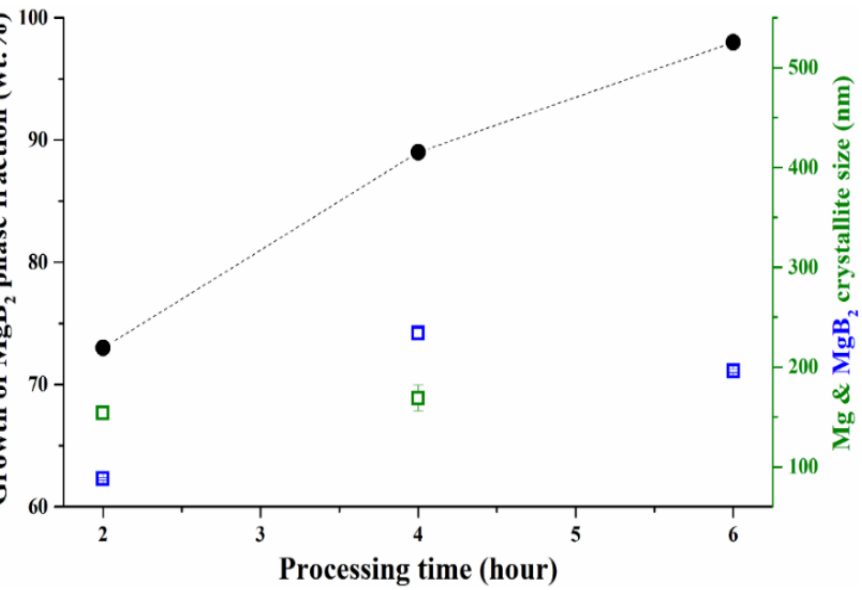
Figure 2. Evolution of the MgB 2 production versus synthesis duration for T = 800 °C and Mg:B stoichiometric ratio equal to 1.4:2. Black solid circles represent the MgB 2 percentage weight fractions, and green and blue void squares are the Mg and MgB 2 crystallite sizes, respectively.